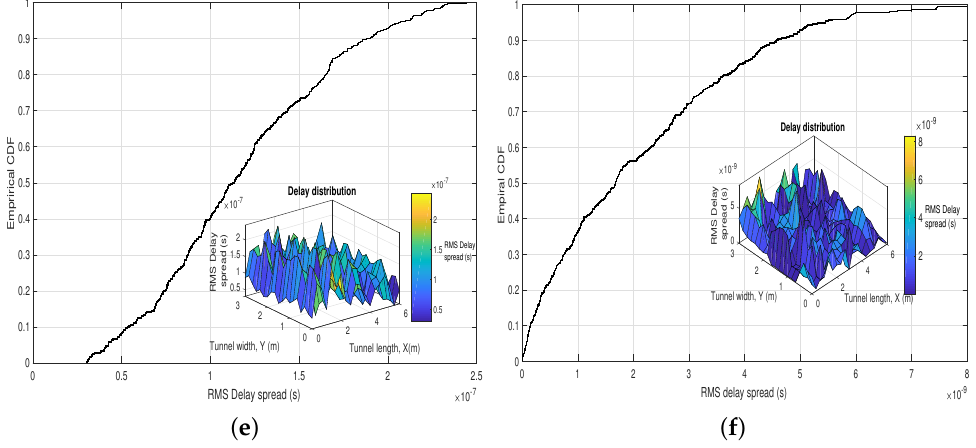
Figure 7. Empirical CDF and distribution of the RMS Delay spread in the UM-VLC scenario with ( a ) 40, ( b ) 60, ( c ) 100, ( d ) 150, ( e ) 200 dust particles in the hemispheric area, and ( f ) UM-VLC reference scenario, Reprinted from ref.